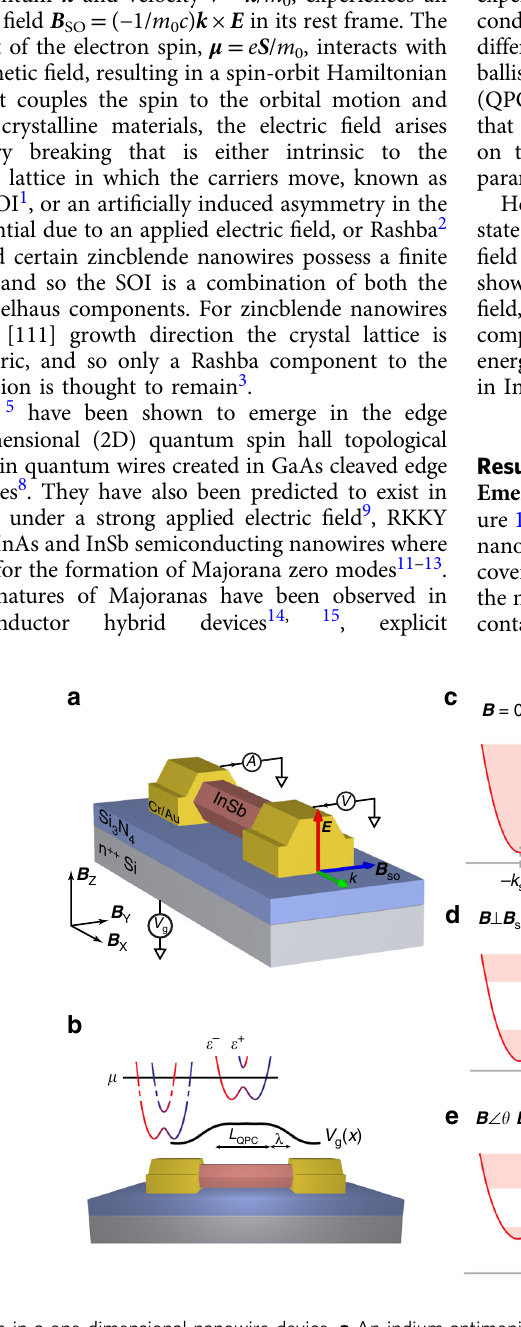
Fig. 1 The helical gap in a one-dimensional nanowire device. a An indium antimonide (InSb) nanowire device with a Rashba spin-orbit fi eld B SO perpendicular to the wave vector k and the electric fi eld E . A voltage is sourced to one contact, and the resulting conductance measured from the second contact. A degenerately doped wafer acts as global backgate V g . b A quantum point contact (QPC) of length L is de fi ned by the two contacts. Underneath the nanowire contacts, many subbands are occupied as the contacts screen the gate electric fi eld. In the nanowire channel away from the contacts, the chemical potential in the wire, μ , is tuned with V g . The onset shape of V g with a lengthscale λ is set by the dielectric and screening of the electric fi eld from the metallic contacts resulting in an effective QPC length L QPC = L − 2 λ . c The energy dispersion of the fi rst two subbands for a system with spin-orbit interaction (SOI) at external magnetic fi eld B = 0 T. The SOI causes subbands to shift by k SO in momentum space, as electrons with opposite spins carry opposite momentum. When the electrochemical potential μ in the wire is tuned conductance plateaus will occur at integer values of G 0 . d At fi nite magnetic fi eld B perpendicular to B SO , the spin polarized bands hybridize opening a helical gap of size E Z ( green ). In this region the conductance reduces from 1 · G 0 to 0.5 · G 0 when μ is positioned inside the gap. e When the magnetic fi eld is orientated at an angle θ to B SO , the size of the helical gap decreases to only include the component of the magnetic fi eld perpendicular to B SO and the two subbands split by an additional Zeeman gap ( purple ). The color scheme illustrating different conductance regimes is also used in Figs. 2d and 3b. For all angles the re-entrant conductance feature at 0.5 · G 0 in the 1 · G 0 plateau will scale linearly with Zeeman